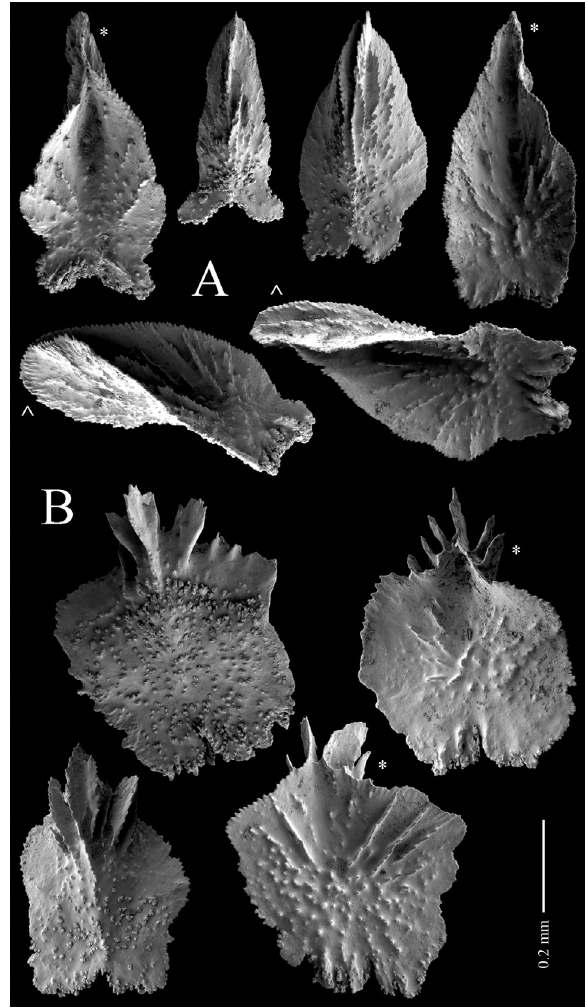
Fig . 13. – Thouarella grandiflora Kükenthal, 1912, holotype (MPUW 44): A, opercular scales; B, marginal scales. [ * outer sur- face view; ^ lateral view].